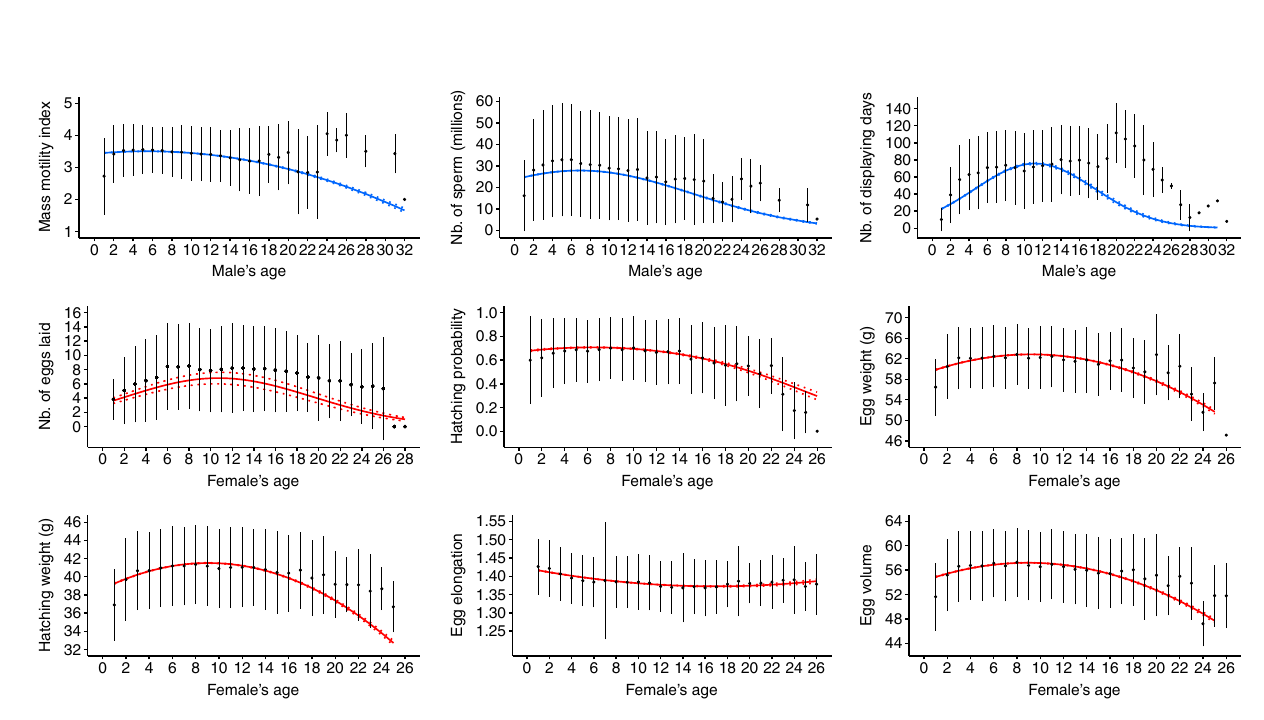
Figure 1. Predicted values of the reproductive parameters according to age. Solid blue lines represent male reproductive parameters while solid red lines represent female reproductive parameters. Dotted lines represent the 95% confidence intervals. Black filled points represent average phenotypic values computed on raw data and the vertical lines represent the associated standard